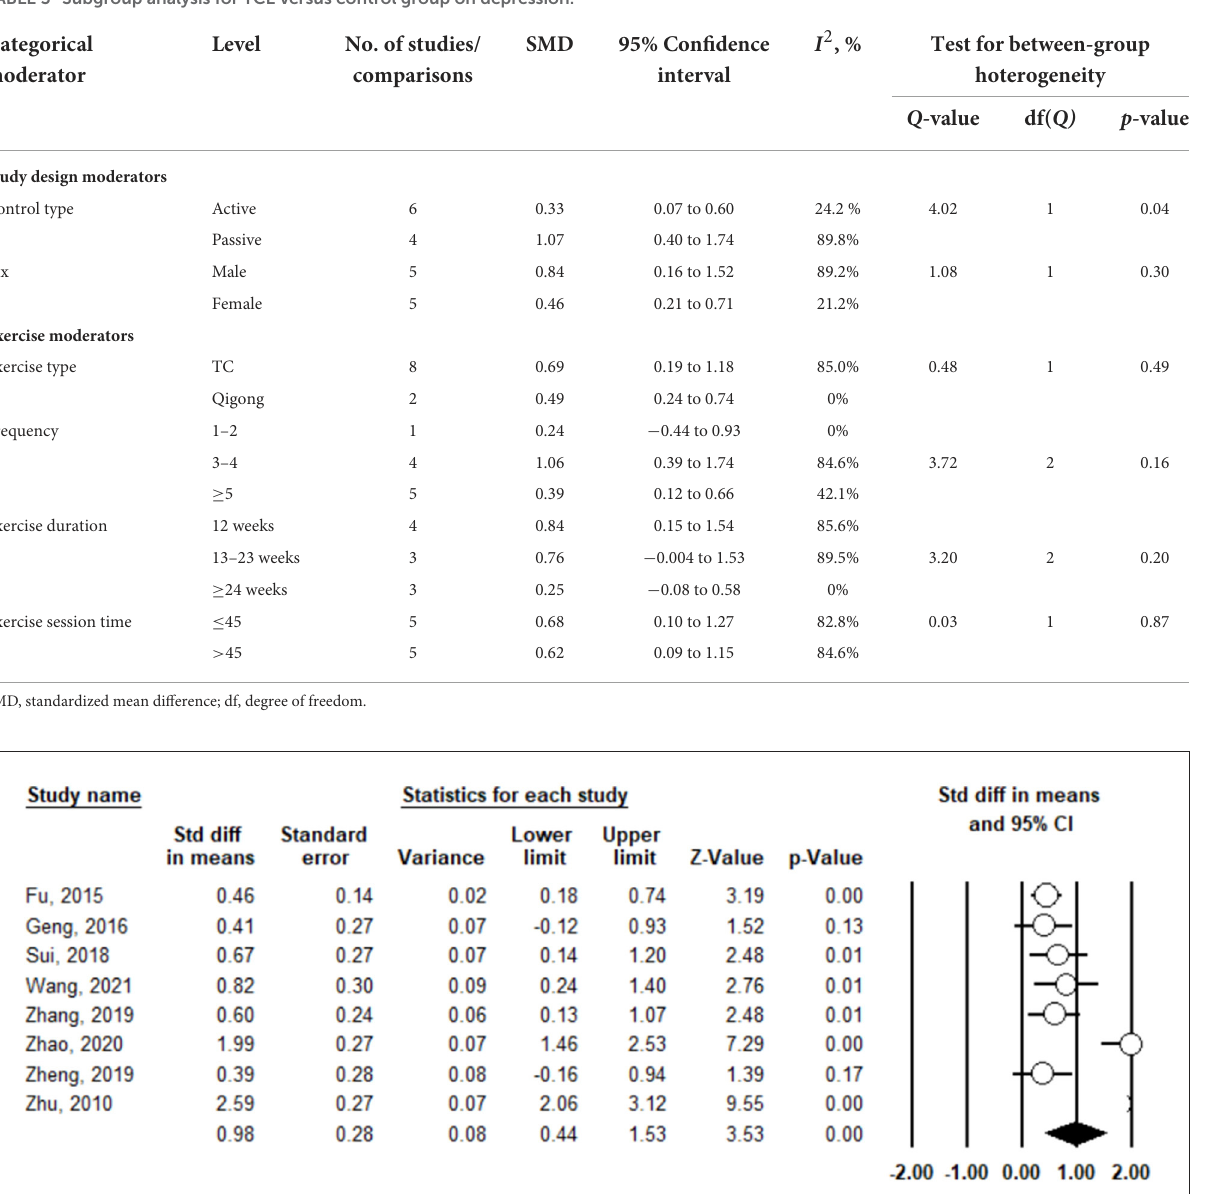
TABLE 3 Subgroup analysis for TCE versus control group on depression.